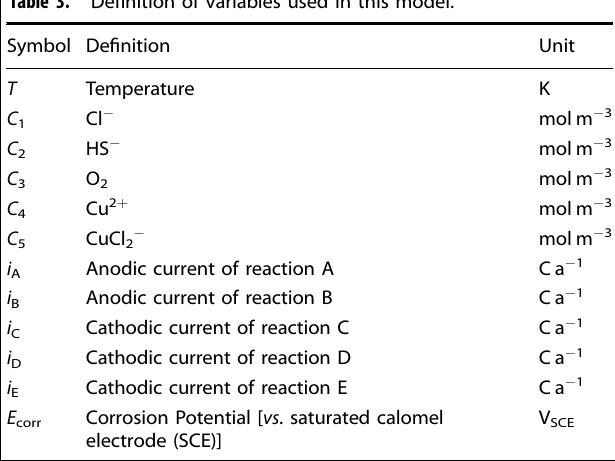
Fig. 18 Logic of developed numerical model. Schematic showing fl ow of mixed-potential model for calculating numerical solutions. Table 3. De fi nition of variables used in this model. Table 4. De